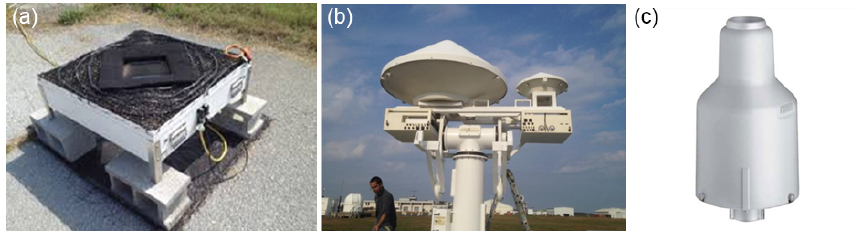
Figure 5. Instruments used in this study: (a) 2DVD (SN37), (b) D3R (dual-wavelength dual-polarized doppler radar), and (c) OTT Pluvio 2 400 precipitation gauge.